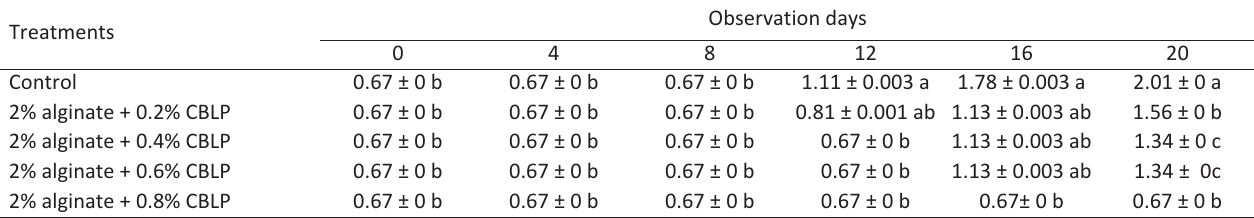
Table 4 ­ Result of total titratable acid in percentage (%) of guava treated with alginate­based edible coating enriched with different concentration of Cyclea barbata leaves